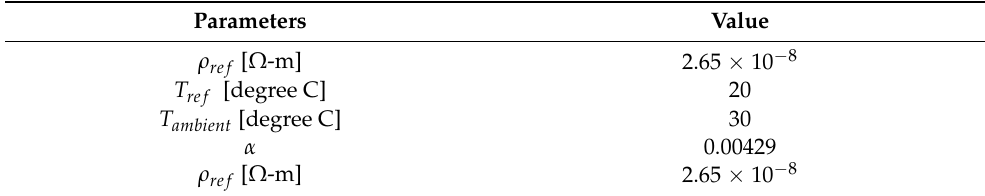
Table 7. Parameter for conductor sizing.